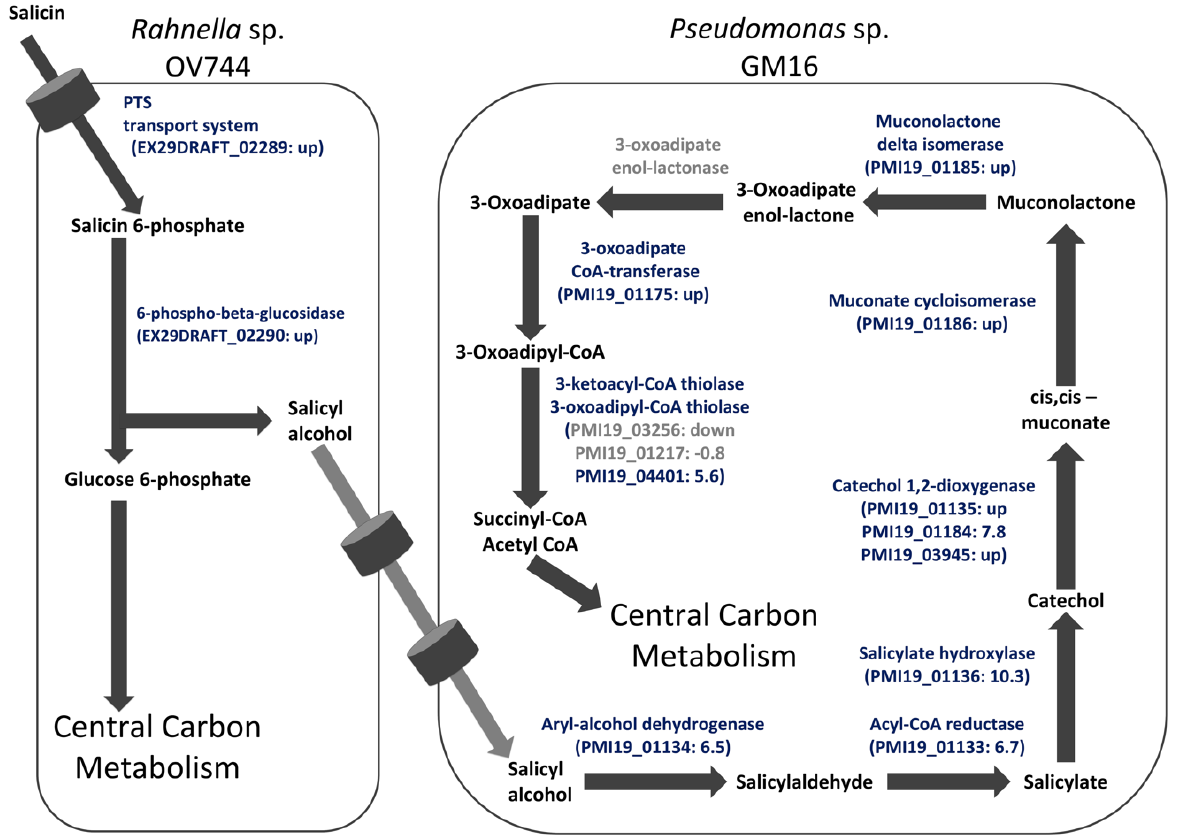
Figure 4. Proteomics data support the salicyl alcohol cross-feeding hypothesis between R. aquatilis OV744 and P. fluorescens GM16 in the salicin co-culture. Proteome data from the Rahnella - Pseudomonas salicin co-culture were compared to data of glucose monocultures of each strain. For Rahnella , proteins of the proposed salicin degradation pathway were upregulated in co-culture compared to glucose monoculture. Similarly, protein expression of Pseudomonas was higher for proteins in co-culture for the proposed salicyl alcohol metabolic pathway than those in glucose monoculture. Values within parentheses represent log 2 ratio of fold change of NSAF values. In cases where the protein was detected in only one culture, the “up” or “down” are reported instead of a fold change. Proteins passing the pfp cutoff are in blue whereas those that did not pass the cutoff are in grey. Some predicted proteins that were not identified as differentially abundant (Tables S8 and S10) are omitted from this figure. For 3-oxoadipate enol-lactonase, none of the proteins were detected reliably in either co-culture or glucose culture. The light grey arrows represent yet to be determined transporters of salicyl alcohol.